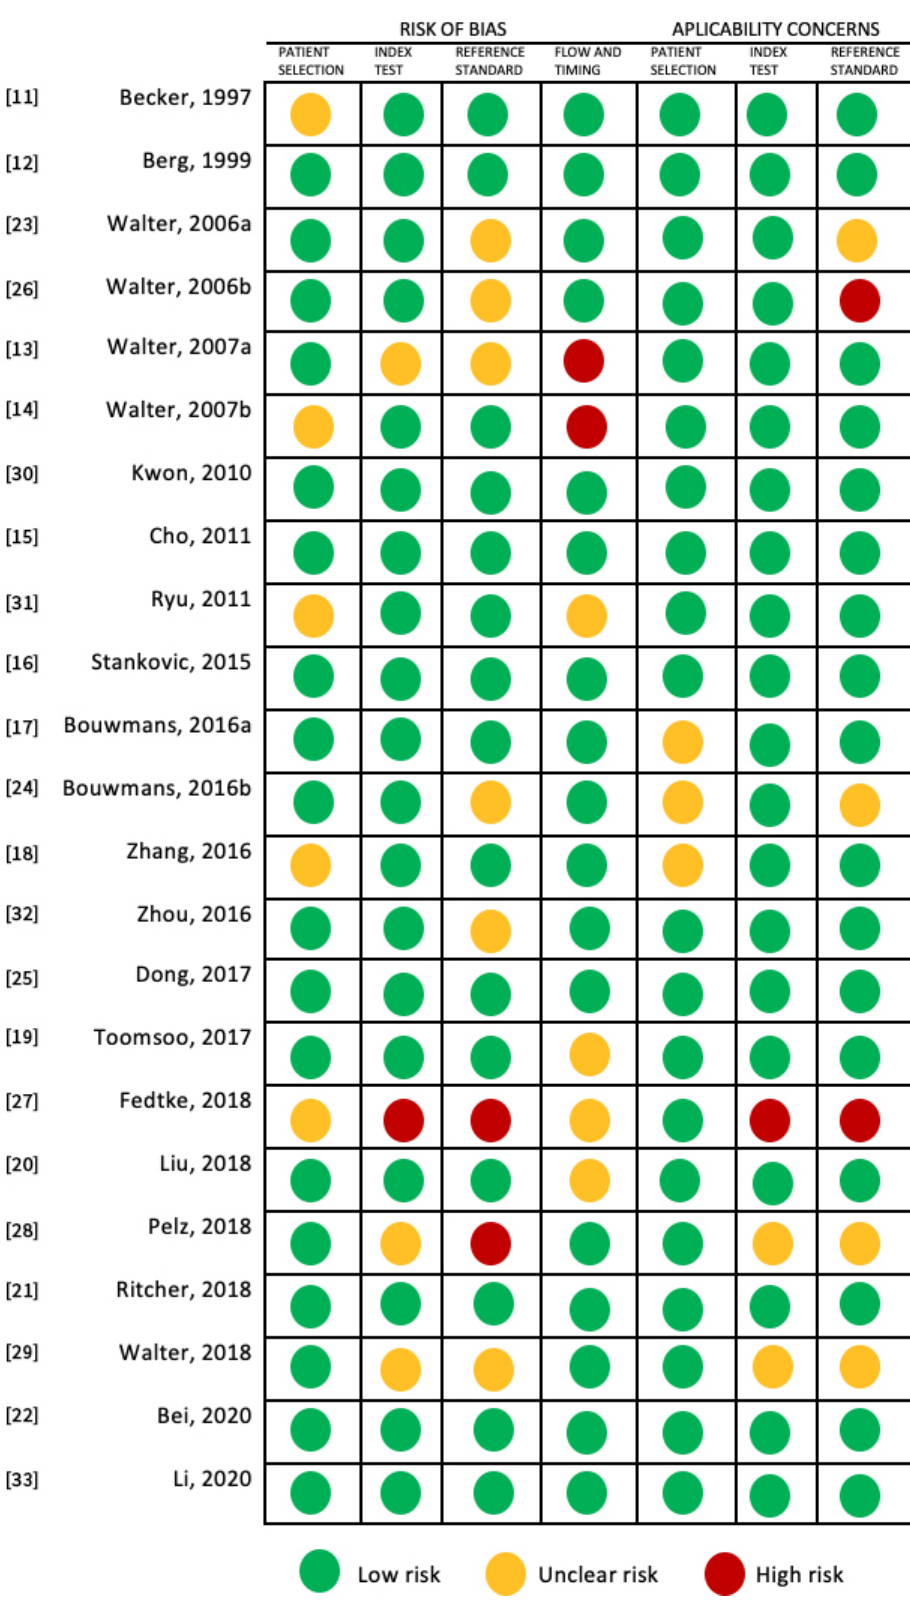
Figure 2. Assessment of risk of bias of studies. QUADAS-2 tool. QUADAS-2, Quality Assessment of Diagnostic Accuracy